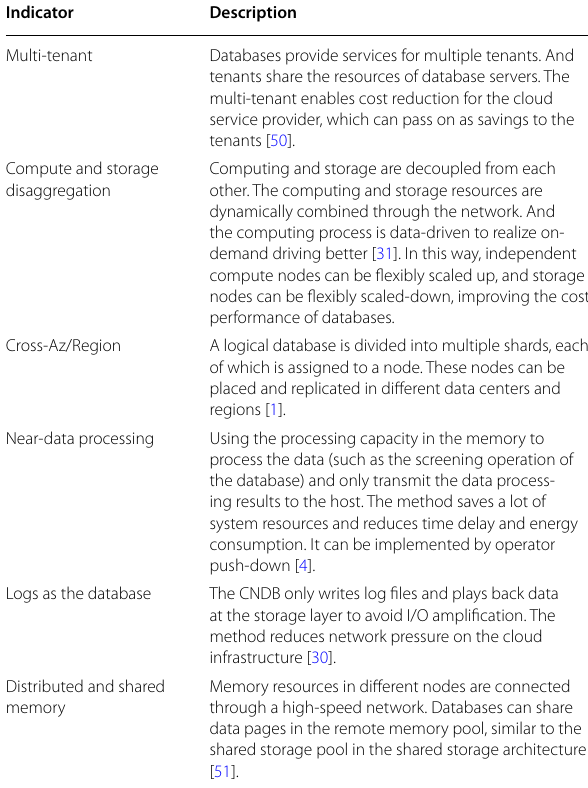
Table 5 dimensions and indicators of the proposed maturity model